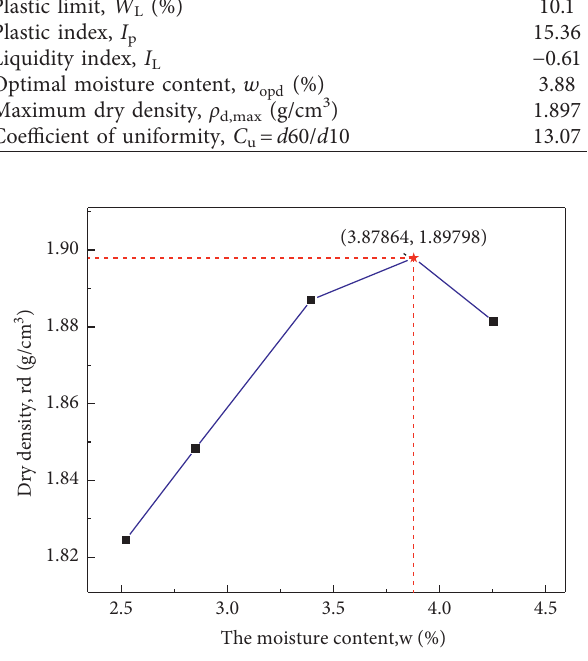
Figure 2: Curve of relation between dry density and water content.